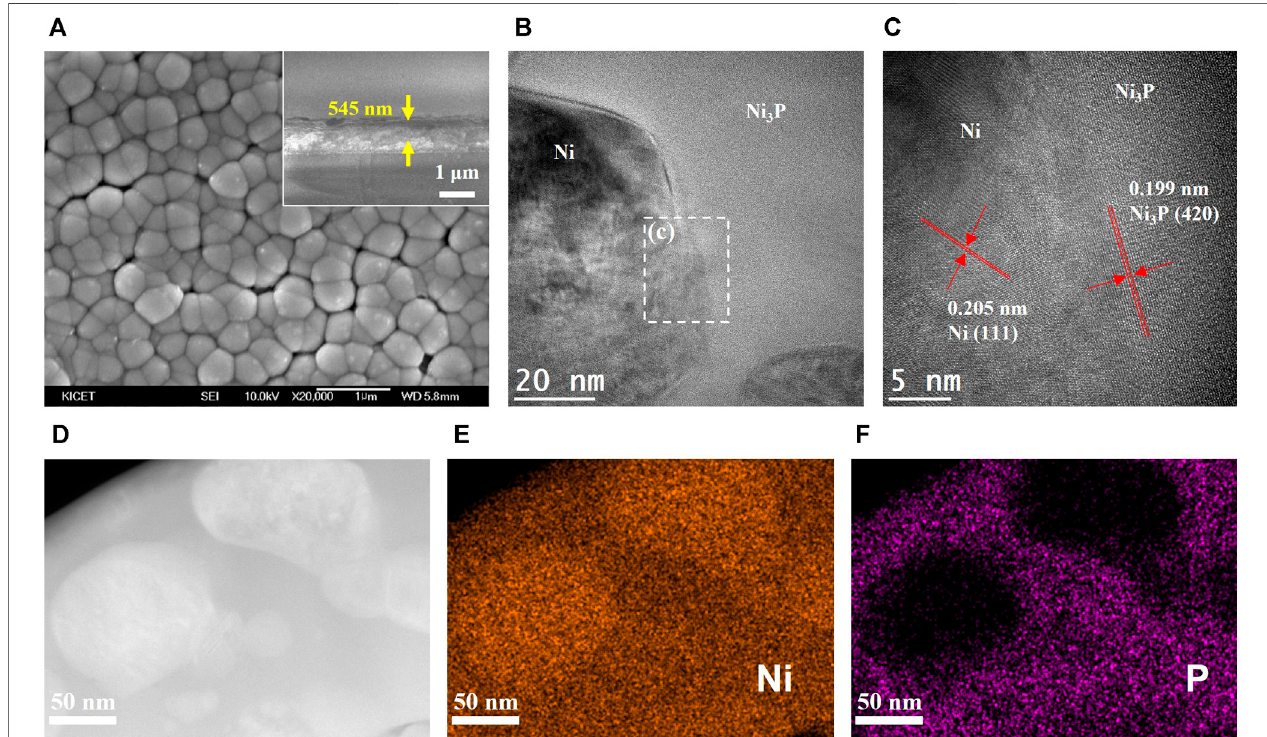
FIGURE6| Structuralcharacterizationofthecrystalline Ni 3 PwithelementalNiinclusionsprepared byannealingofamorphousNi 69 P 31 electrodeposit: (A) FE-SEM image (SEM scale bar and thickness display), (B) bright- fi eld TEM image, (C) HRTEM image, (D) STEM image, and (E, F) EDS elemental mapping for Ni and